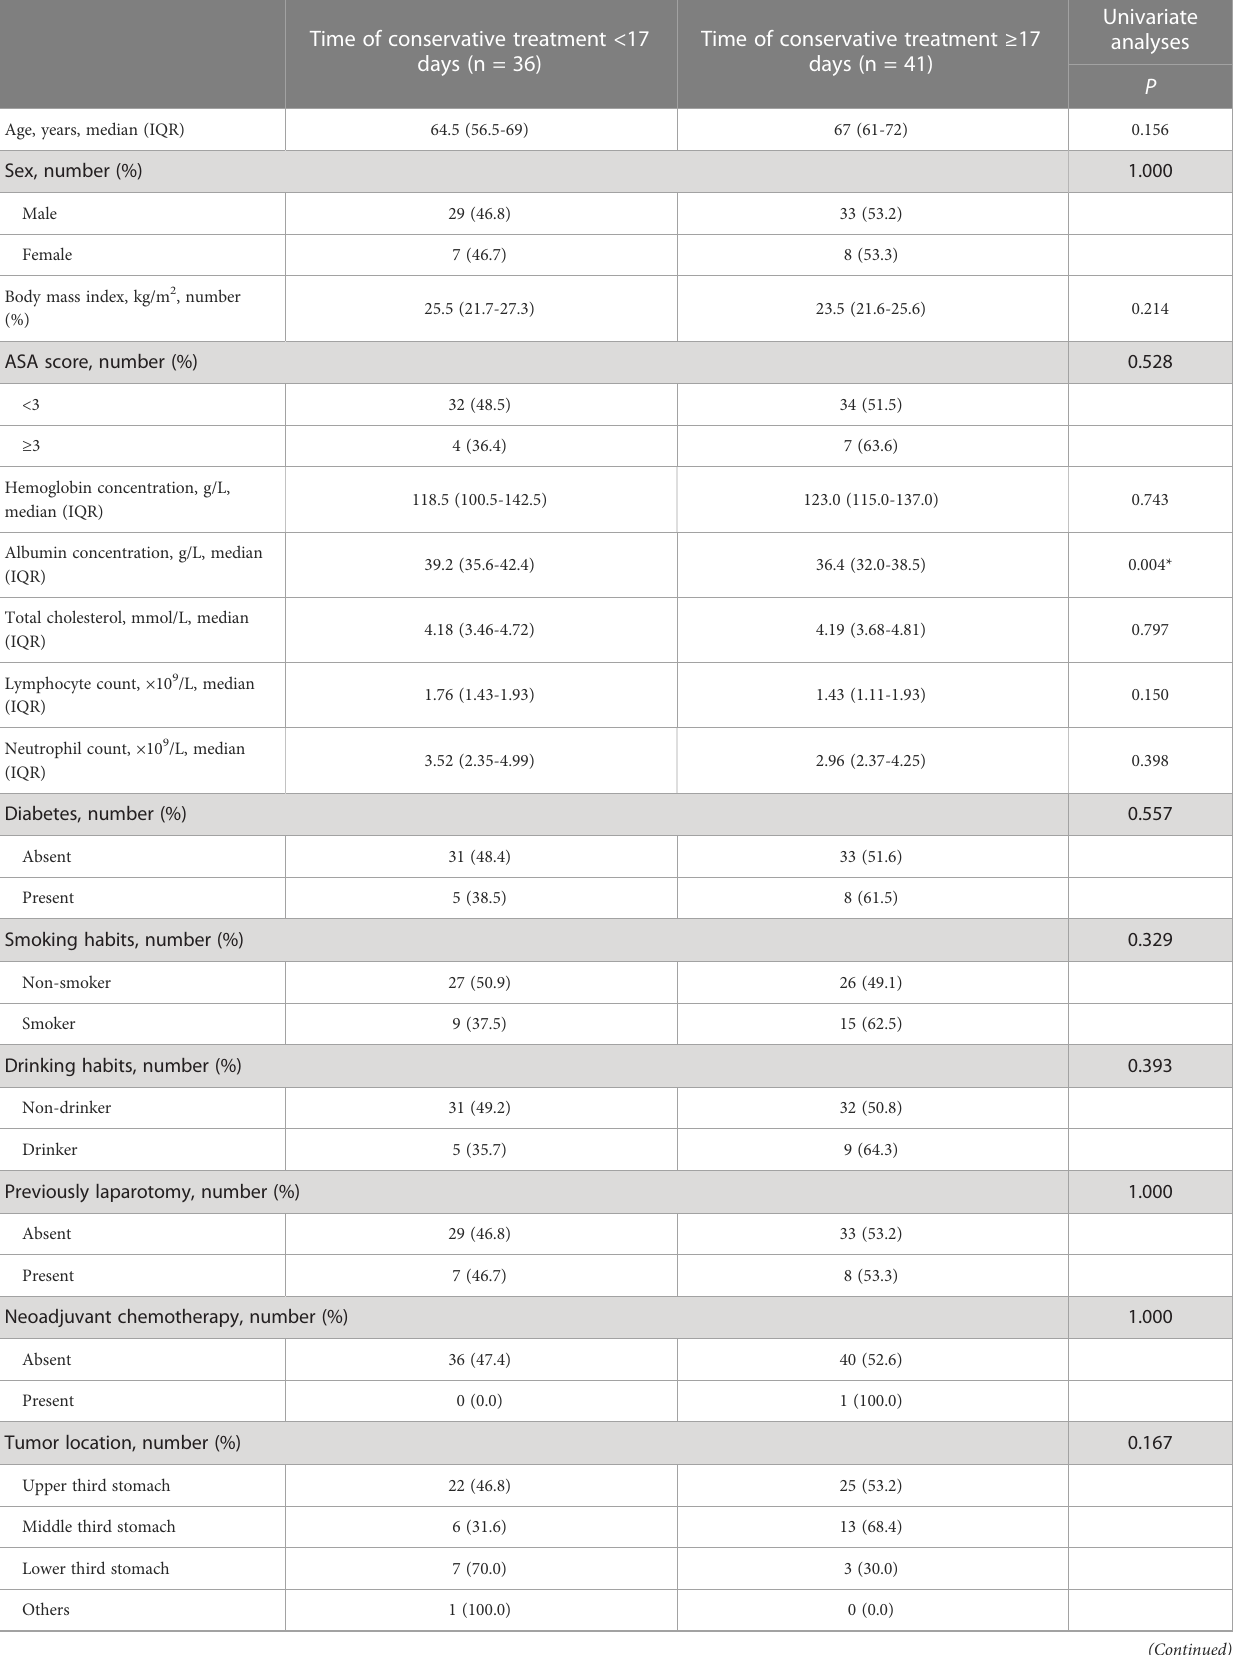
TABLE 7 Univariate analyses to identify clinicopathological and operative variables that are associated with the time of conservative